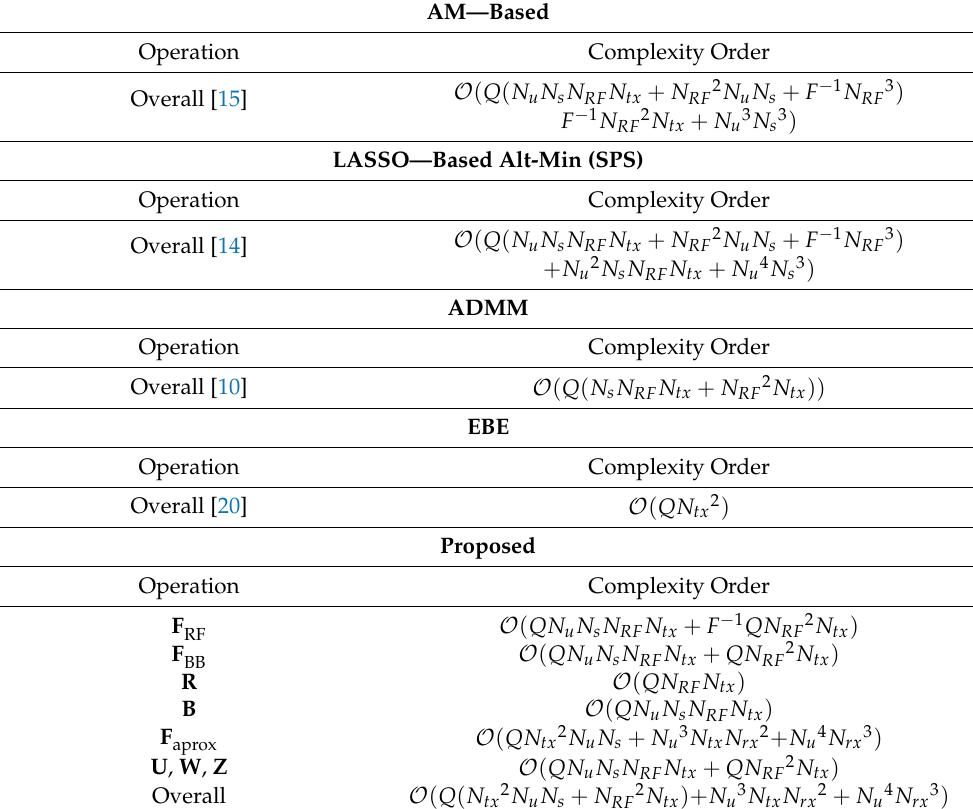
Table 2. Overall Complexity of Different Hybrid Precoding Algorithms (per